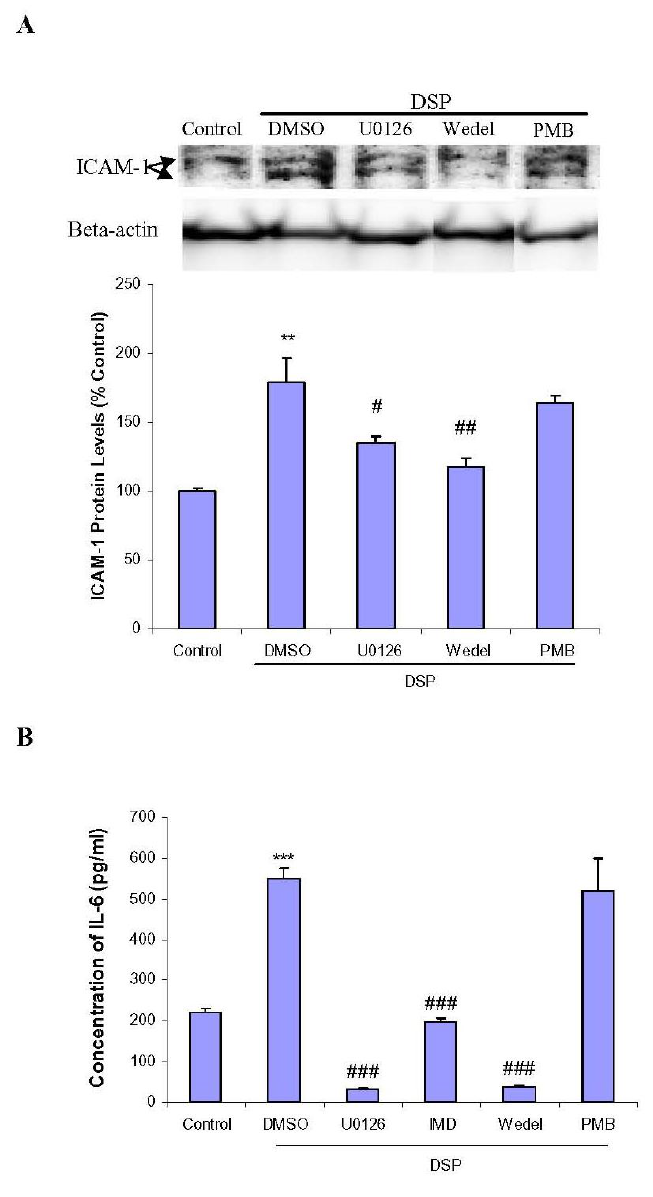
FIGURE 4. DSPs induce release of IL-6 and expression of ICAM-1 through activation of ERK1/2 and NF-κB in human VSMCs. Serum-starved cells were treated with 0.2 μl/ml of DSPs for 24 h. 10 μM of U0126, 5 μM of wedelolactone, 30 nM of IMD-0354, or 30 μg/ml polymyxin B were added to cells 30 min prior to treatment with DSPs. (A) Bar graphs show the effects of inhibitors on DSP-induced expression of ICAM-1. The upper panels indicate representative autoradiographs of western blot. (B) Bar graphs show the effects of inhibitors on DSP-induced release of IL-6 as determined by ELISA. Data represent mean ± S.E.M. ** p < 0.01, *** p < 0.001 vs. control; # p < 0.05, ## p < 0.01, ### p < 0.001 vs. DMSO; Wedel = wedelolactone; IMD = IMD-0354; PMB = polymyxin